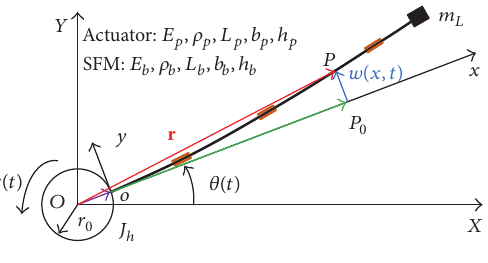
Figure 1: Structural diagram of the